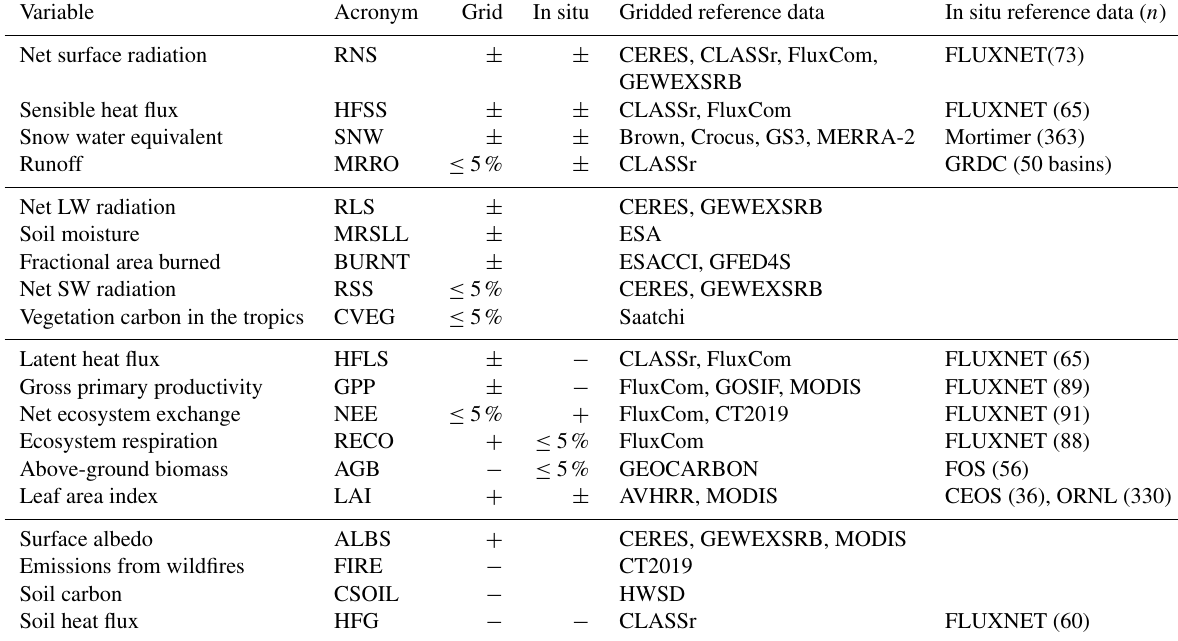
Table 2. Qualitative assessment of global mean biases. Variables for which positive and negative mean biases are found are denoted with ± . Biases that have a consistent sign across all evaluations but are smaller than ± 5% are marked with ≤ 5%. Larger systematic biases are marked with + or − . Numbers provided for each of the in situ reference data refer to the number of grid cells